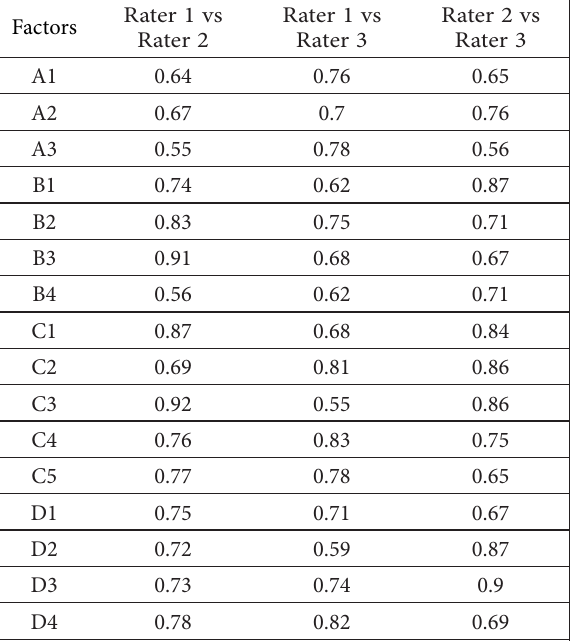
Table 7. Inter-rater reliability